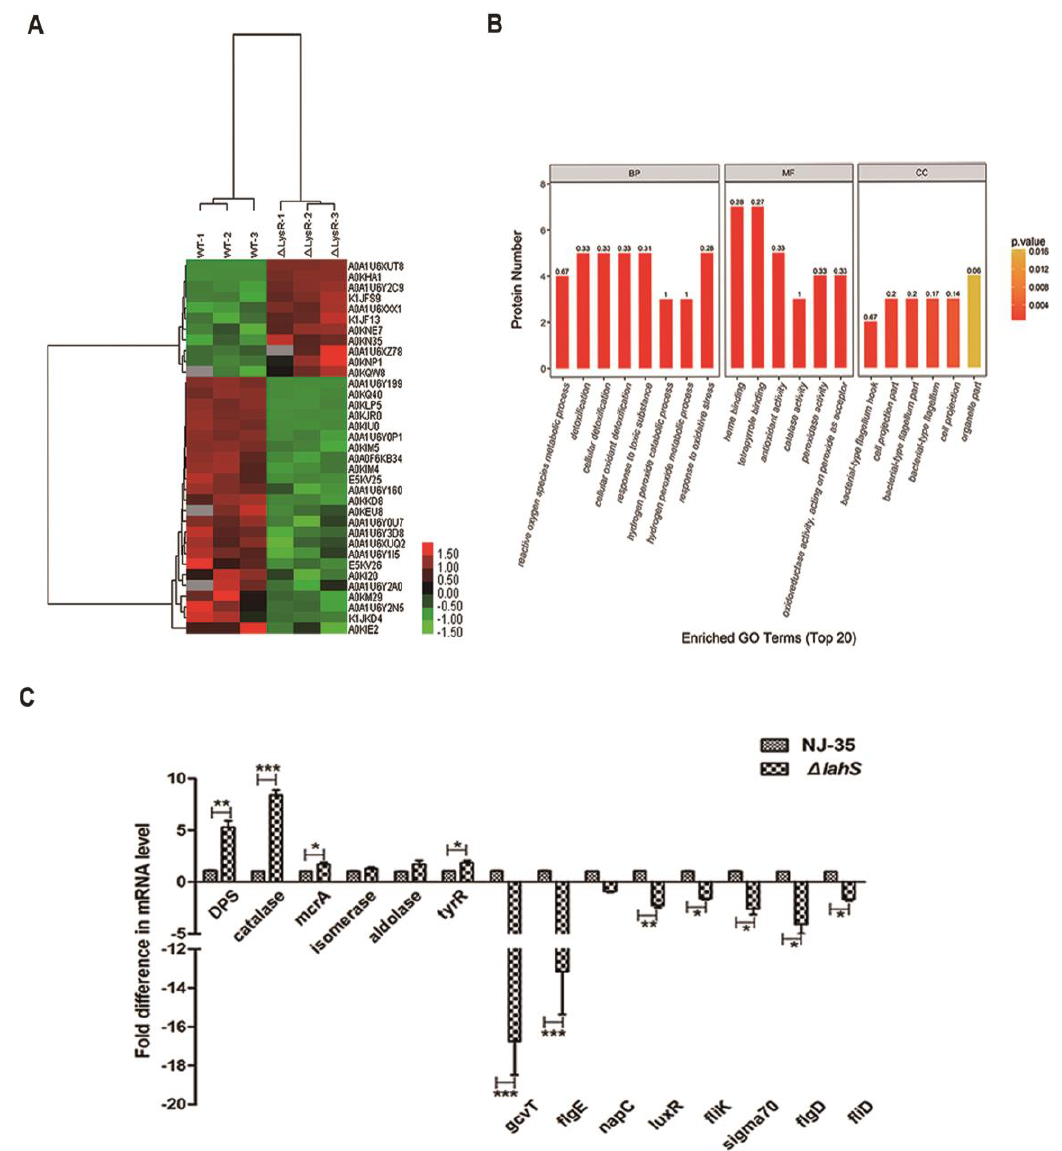
Figure 10. Label-free quantitative proteomics analysis of differentially expressed proteins between the wild-type and lahS mutant strains. ( A ) Heat map of the 34 identified proteins. Up- and down-regulated proteins are indicated in shades of green (increased) and red (decreased), respectively. ( B ) Gene Ontology (GO) classification of differentially expressed proteins. The differentially expressed proteins are grouped into three hierarchically structured terms: biological process, cellular component, and molecular function. ( C ) Relative mRNA expression levels of 14 genes coding the differentially expressed proteins in lahS mutant and wild-type strains. The results were expressed as n-fold increases with respect to the control. Data are presented as the means ± SEM from three independent experiments. * p < 0.05, ** p < 0.01 or *** p < 0.001.